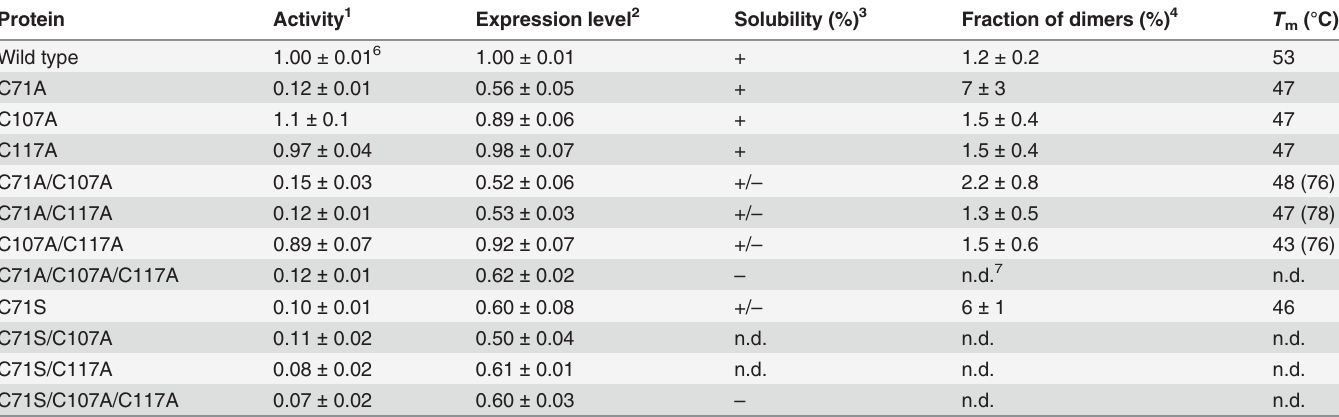
Table 1. Activity, stability, and structural properties of the wild type and mutant aldehyde deformylating oxygenases (ADs).